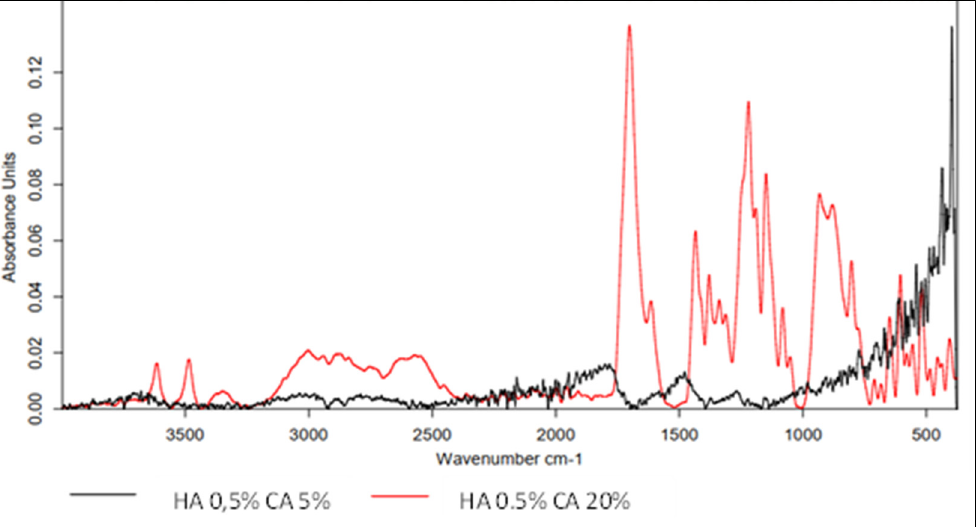
Figure 12. IR spectrum for 0.5% hyaluronic-acid-coated carbon nonwoven samples cross-linked with citric acid of different concentrations (5%—black line; 20%—red line).